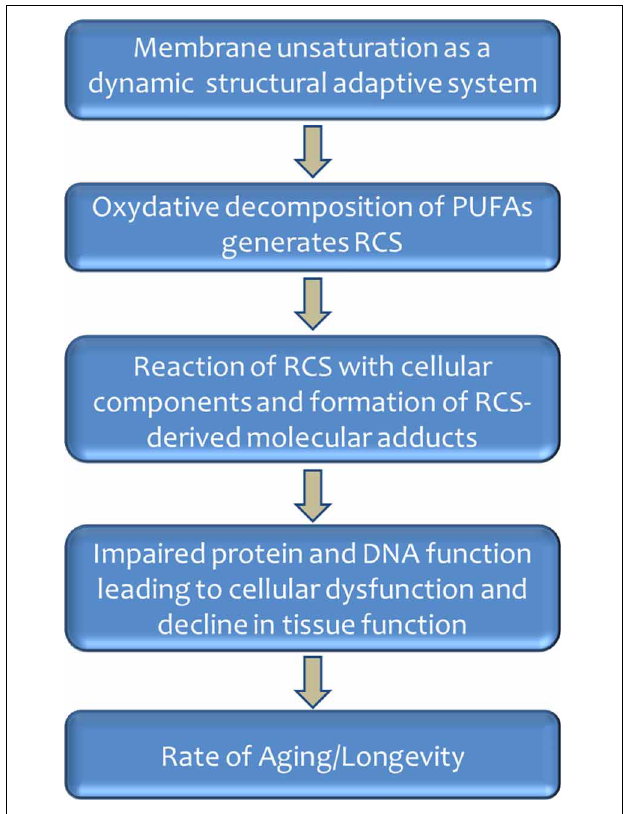
FIGURE 3 | Role of membrane unsaturation and lipoxidation-derived molecular damage in aging and